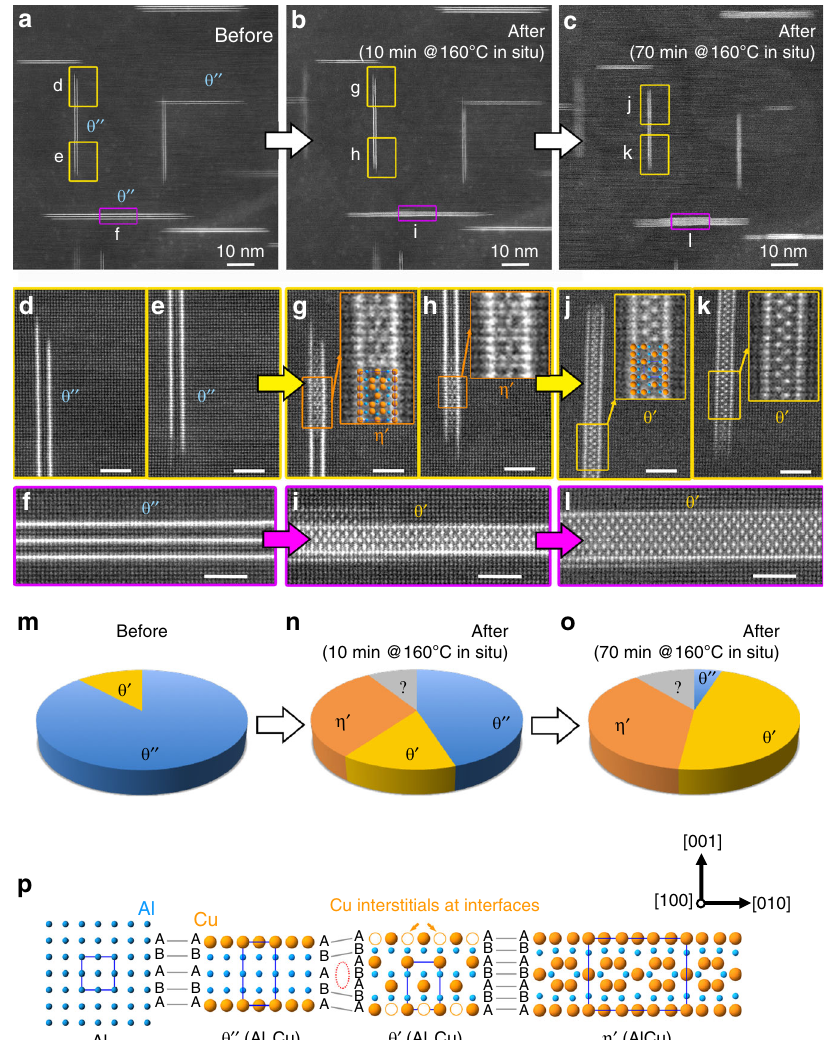
Fig. 2 Template-directed nucleation (TDN) of the θ ′ phase and an unexpected phase, which we denote η ′ , on the template θ ″ phase, as promoted by in situ heating in the TEM. a , d – f Show a region and its θ ″ precipitates following a conventional bulk heat treatment of 24 h at 160 °C, before in situ heating. b , g – i , c , j – l Show the same region and precipitates after in situ heating for 10 min and 70 min at 160 °C, respectively. The θ ′ and η ′ phases have nucleated within the θ ″ precipitates. The scale bars in d – l correspond to 2 nm. m – o Show the proportion of precipitate type ( θ ″ , θ ′ and η ′ ) for each of the three conditions and for the same sample region, of thickness 37 ± 5 nm and containing >100 precipitates. The η ′ phase nucleates in greater numbers early on, but is progressively replaced by θ ′ . The grey portion marked “ ? ” refers to nuclei, θ ′ or η ′ , that could not be identi fi ed. p illustrates the strong structural relationships between the different phases (viewed along [100]), except for atomic planes indicated by a dotted